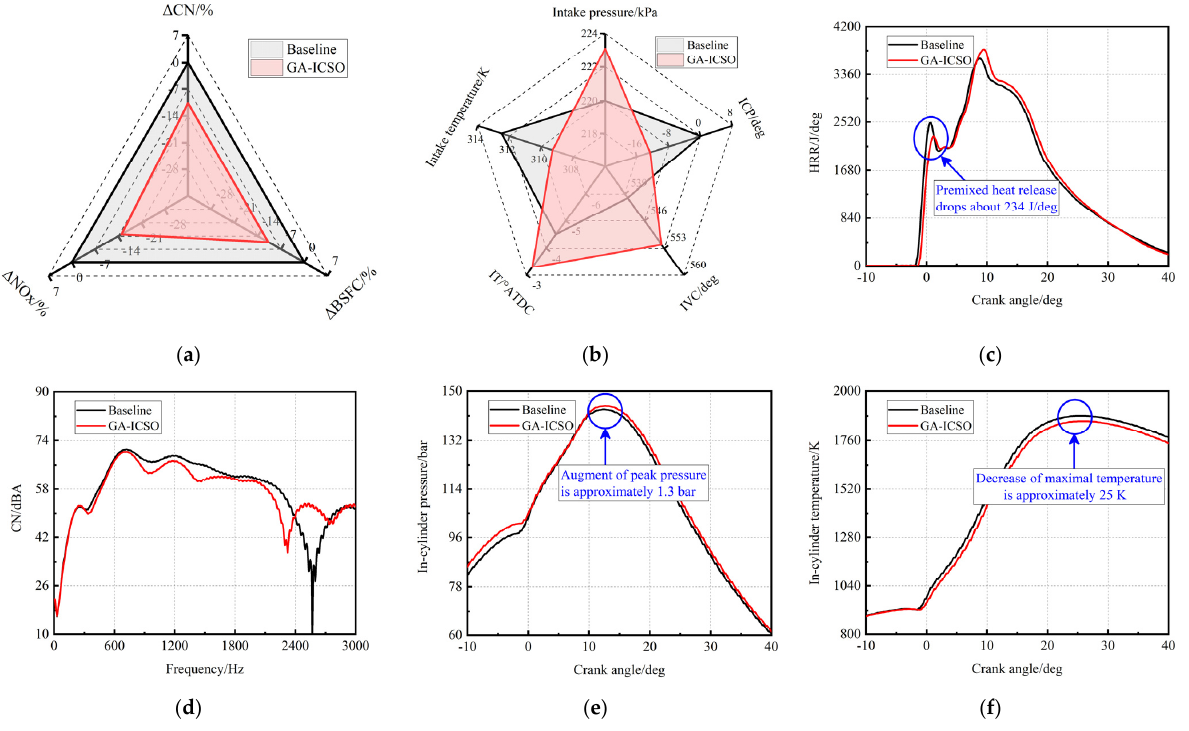
Figure 16. Comparisons between optimization results and baseline for the condition of 50% load: ( a ) Optimization percentage convergence; ( b ) Engine control variables; ( c ) HRR; ( d ) Combustion noise spectrum; ( e ) In-cylinder pressure; ( f ) In-cylinder temperature.